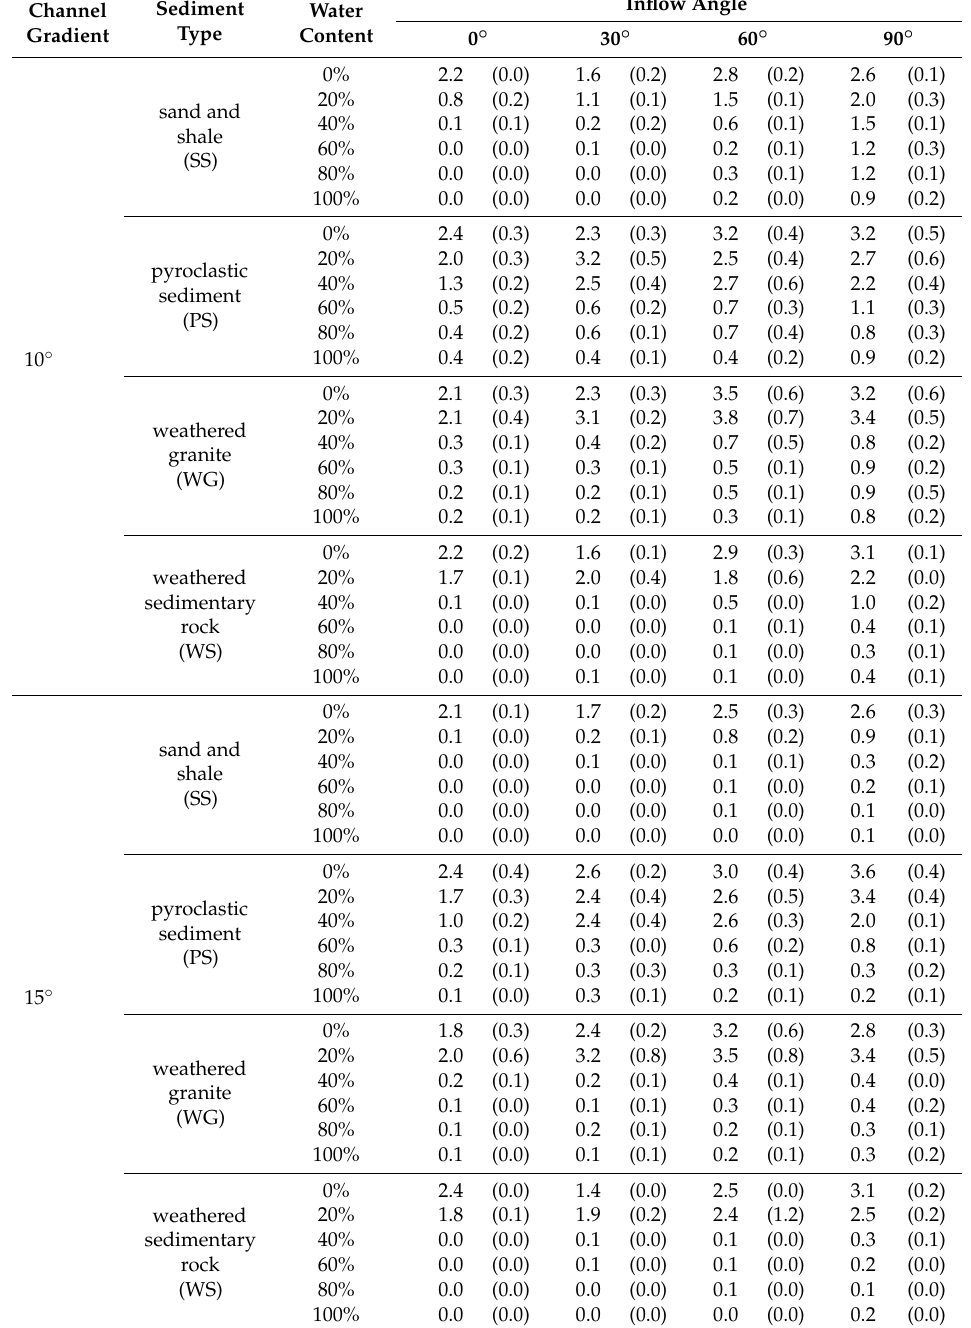
Table A5. Summary of sediment thickness at the hillslope-channel junction (section B, in cm). Values in parentheses indicate standard